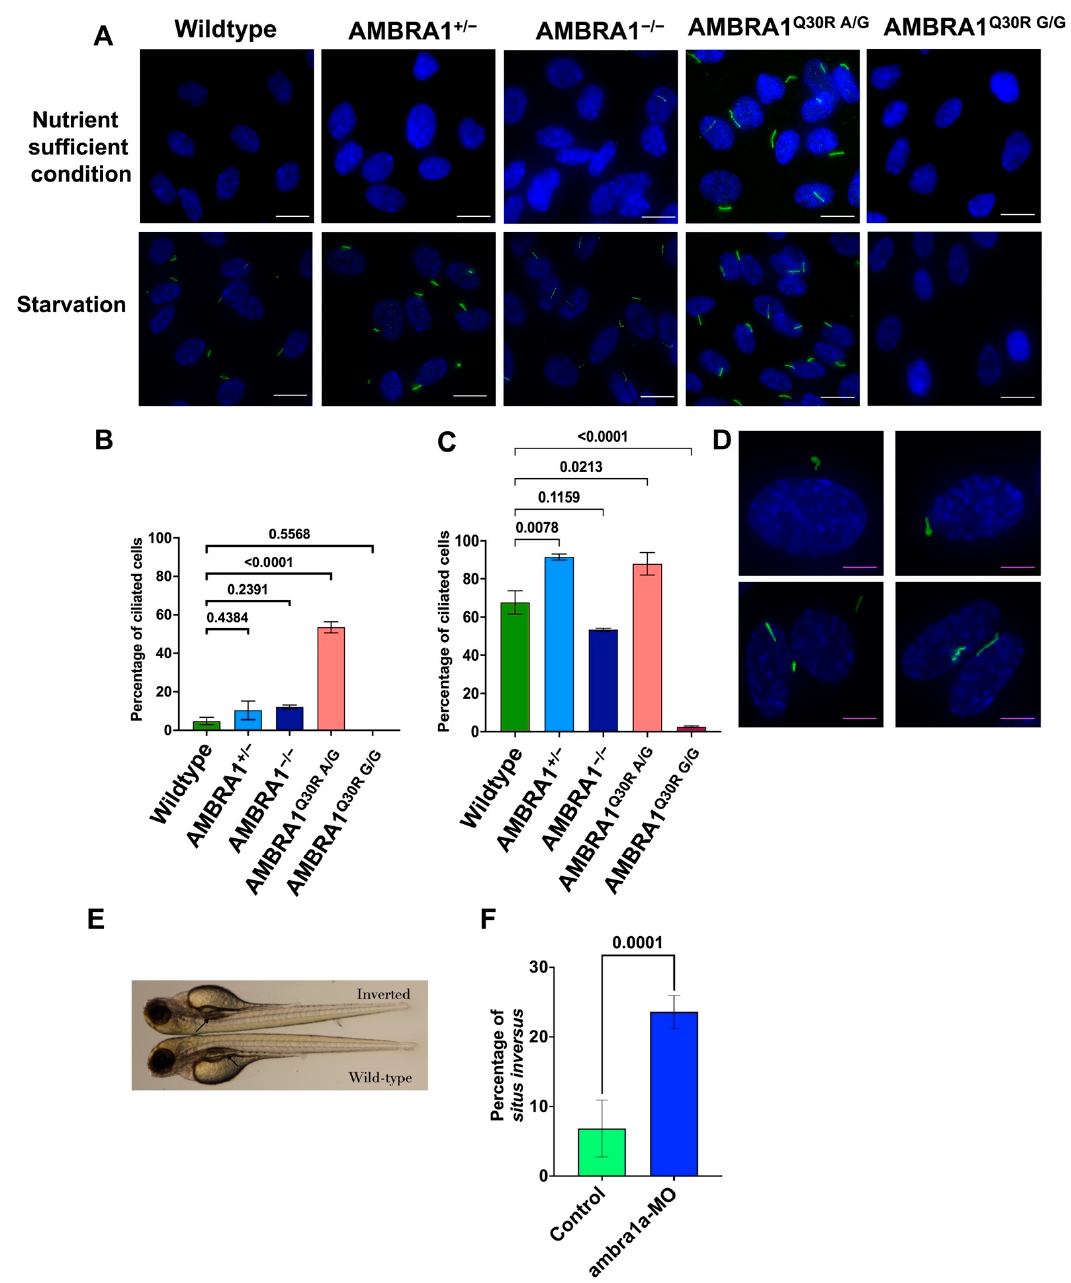
Figure 3. AMBRA1 Q30R mutant hTERT-RPE1 cells exhibited abnormal primary ciliogenesis. ( A ) Immunocytochemistry images of cells stained with Arl13B (ADP Ribosylation Factor Like GTPase 13B), a primary cilia marker (stained green), and DAPI (4 (cid:48) ,6-diamidino-2-phenylindole), a nucleus marker (stained blue). White scale bar=25 µ m ( B ) Bar graph representing the percentage of ciliated cells in each AMBRA1 genotype in nutrient-sufficient condition. Statistical significance was determined by ANOVA. ( C ) Bar graph representing the percentage of ciliated cells in each AMBRA1 genotype under starvation. Statistical significance was determined by ANOVA. ( D ) Representative immunocytochemistry images of AMBRA1 Q30R A/G mutant cells stained with Arl13B and DAPI, showing abnormal ciliary structures (curled—top; double cilia—bottom left; spiral—bottom right). Magenta scale bar=15 µ m ( E ) ambra1a zebrafish CRISPANT showing a situs inversus phenotype. The arrow indicates the reverse orientation of the gall bladder in ambra1a knockout zebrafish (top) and its normal orientation in wildtype zebrafish (bot- tom). ( F ) Bar graph representing the percentage of zebrafish showing situs inversus phenotype. Statistical significance was determined using Fisher’s exact